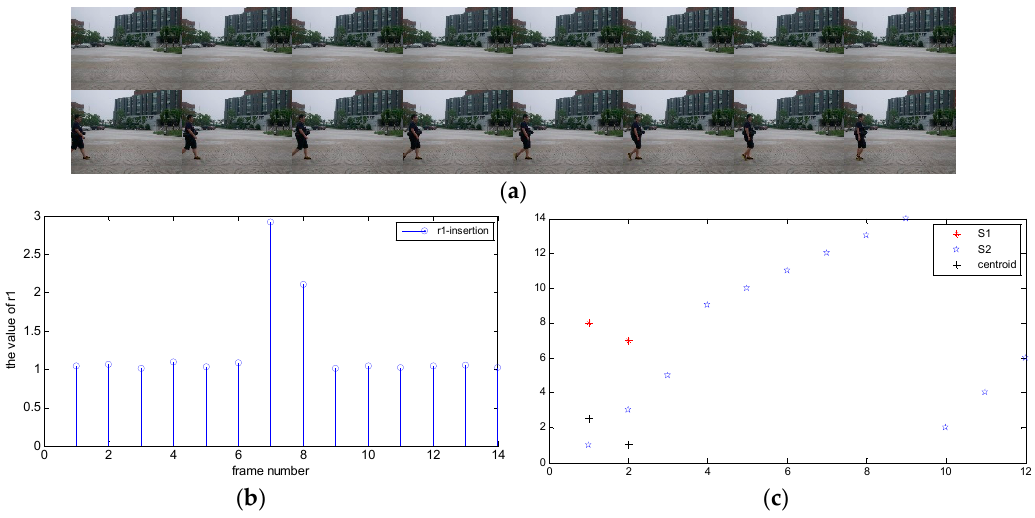
Figure 7. Frame insertion and clustering results. (a) Sixteen frames from a video tampered by frame insertion; (b) The curve of ∆r1 ; (c) clustering results.